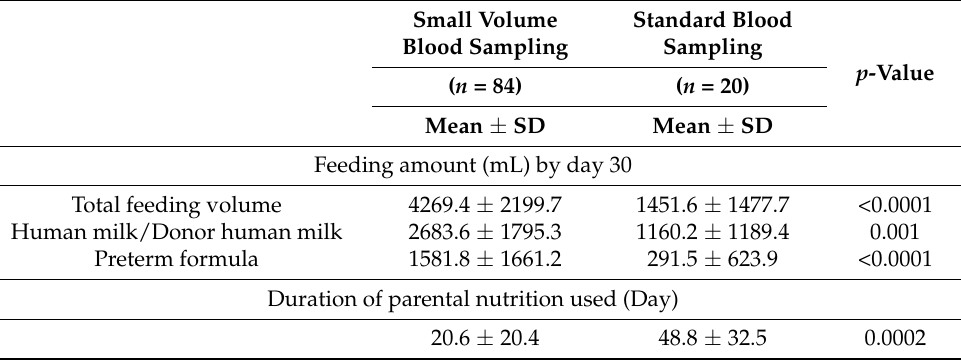
Table 3. Nutrition